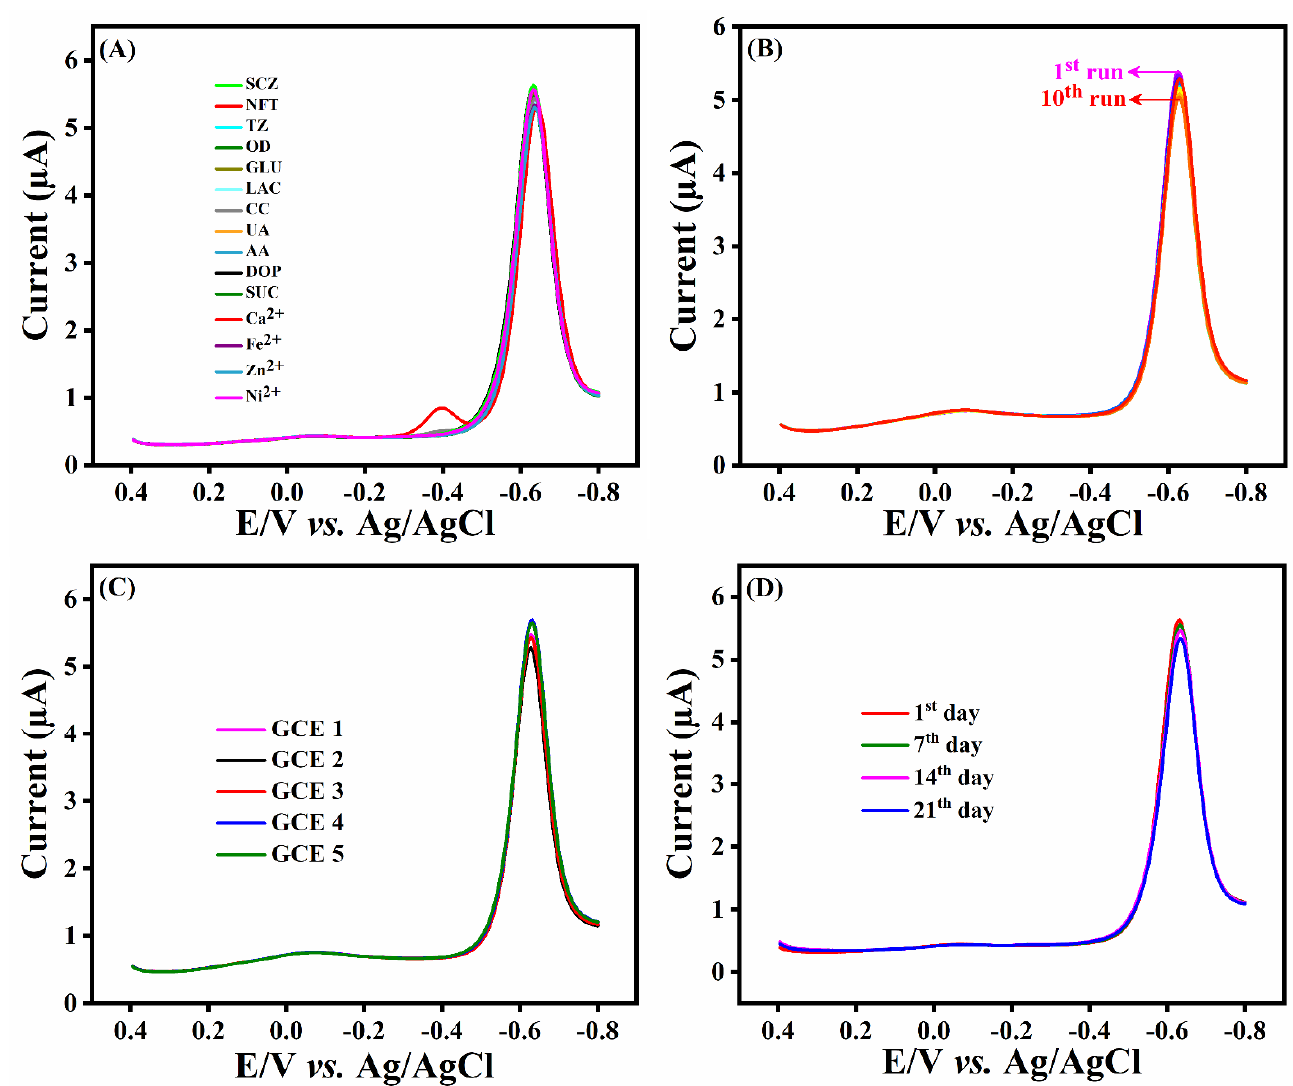
Figure 8. ( A ) Selectivity studies at ZTO/TO MPs/GCE for 50 µ M SCZ. ( B ) Repeatability, ( C ) reproducibility, and ( D ) storage stability studies for 50 µ M under an N 2 atmosphere in pH